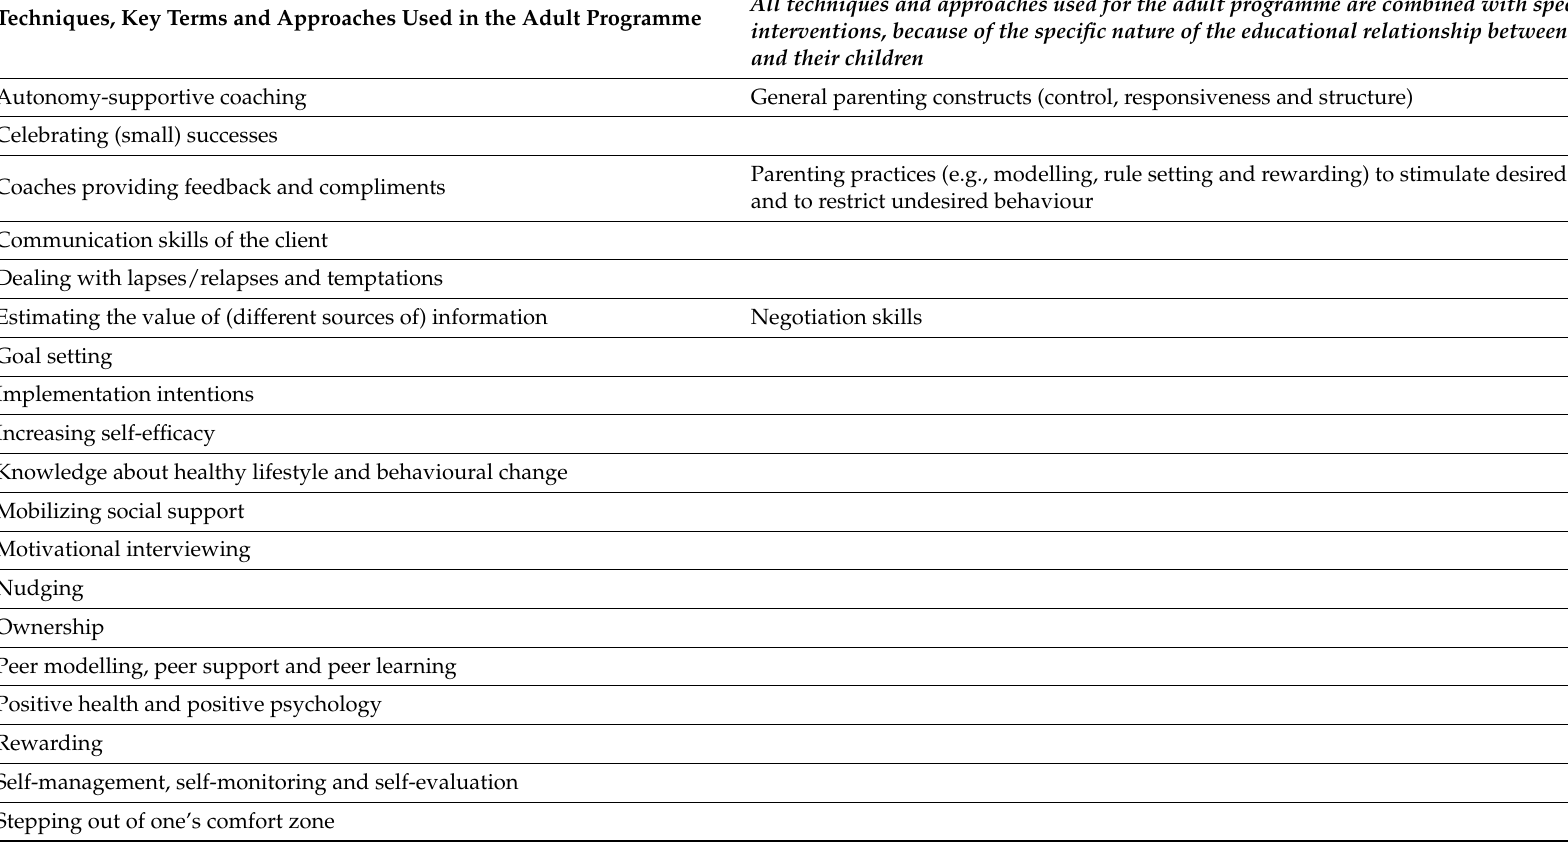
Table A1. Techniques and approaches used in the Coaching on Lifestyle (CooL)